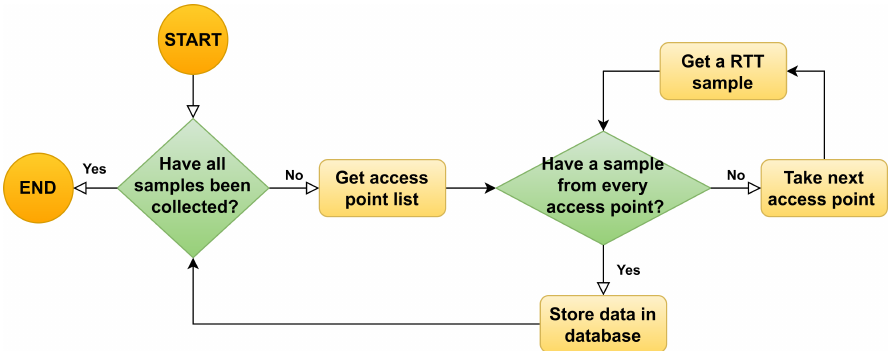
Figure 4. Procedure followed to collect the RTT samples at one reference point in the